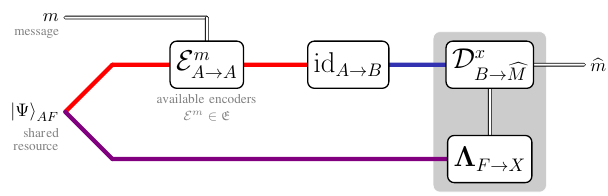
FIG. 4. A dense coding protocol for the shared resourceful quantum state (cid:2) AF under one-way LOCC decoders (shaded area). In this protocol, Alice possesses system A (red line), Bob possesses system B (blue line), and Fred possesses system F (purple